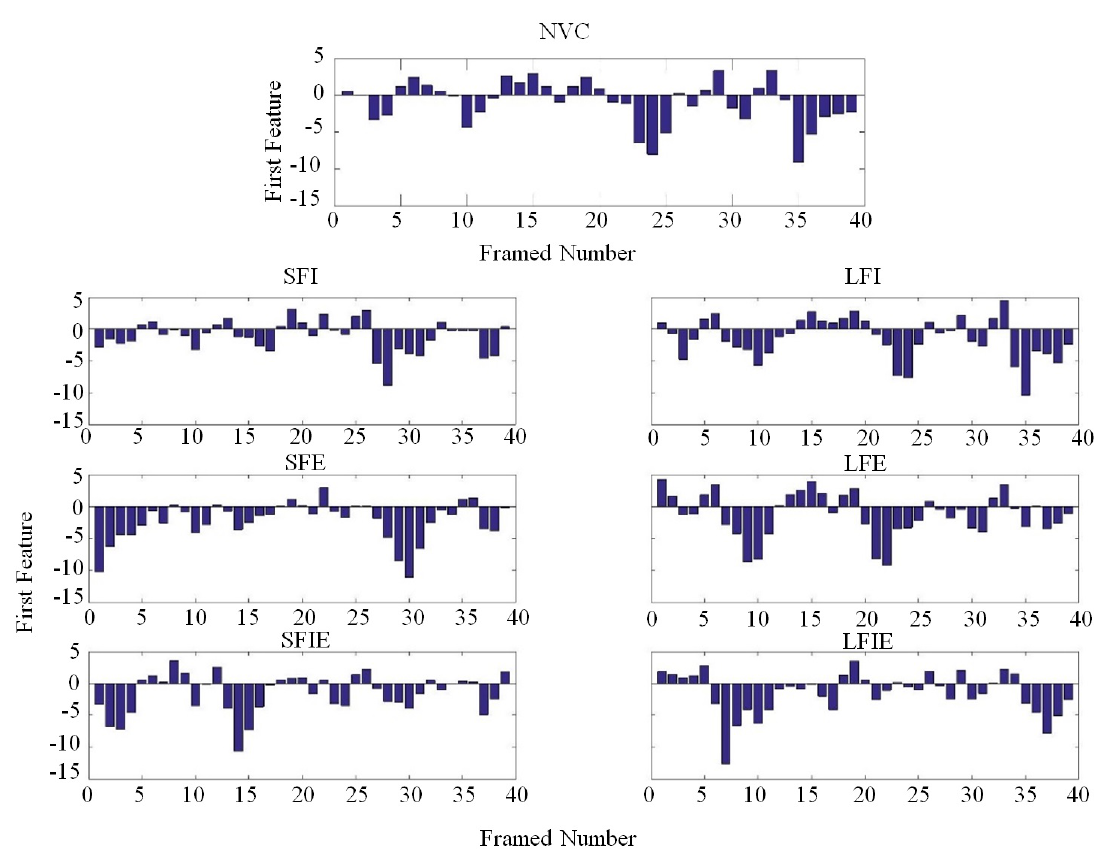
Figure 11. First feature diagrams of the improved VMD-MFCC (IVMD-MFCC) with various